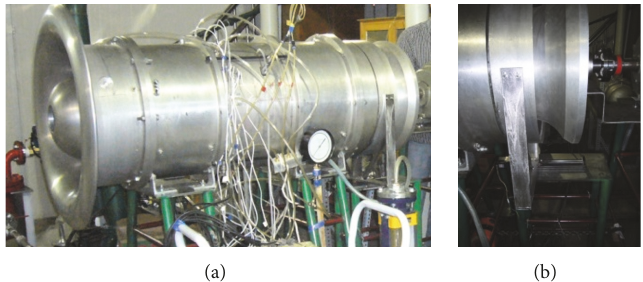
Figure 2: Picture of (a) side view of the one-stage axial compressor system and (b) view of the throttle using a cone movement system for controlling the flow coefficient and pressure rise.